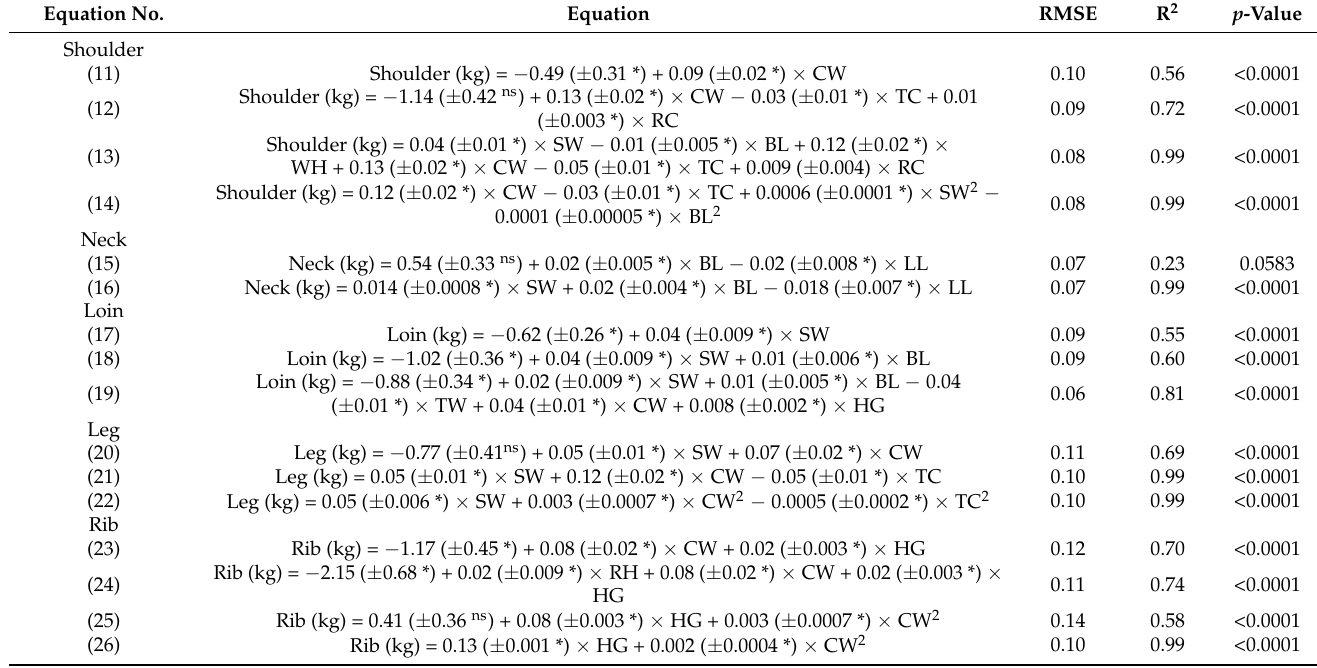
Table 4. Regression equations for predicting the weights of primal cuts from the carcass of wool-less sheep finished in tropical pastures through biometric measurements. Values in parentheses are the PEs of the parameter estimates. Equation